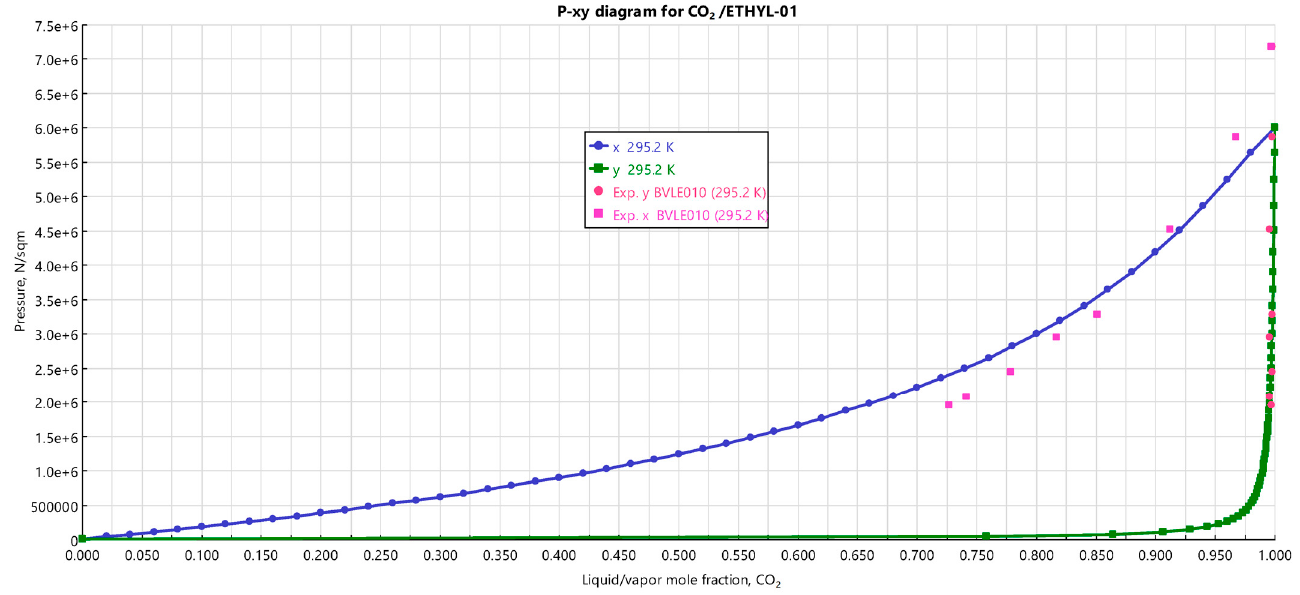
Figure 3. Experimental [25] and correlated data with Peng–Robinson equation of state with Wong– Sandler mixing rules for the system CO 2 /ethyl acetate, at 22 °C (295 K).